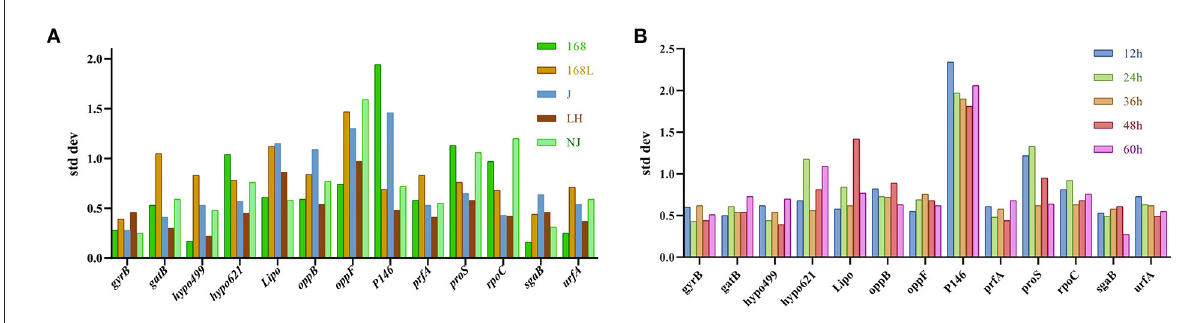
FIGURE5 Analysis of internal reference gene standard deviation (SD) using the BestKeeper software. The x-axis represents various candidate reference genes. The y-axis represents stability value. (A) : SD value of reference gene of the same strain at different culture times. (B) : SD value of reference gene of different strains at the same culture